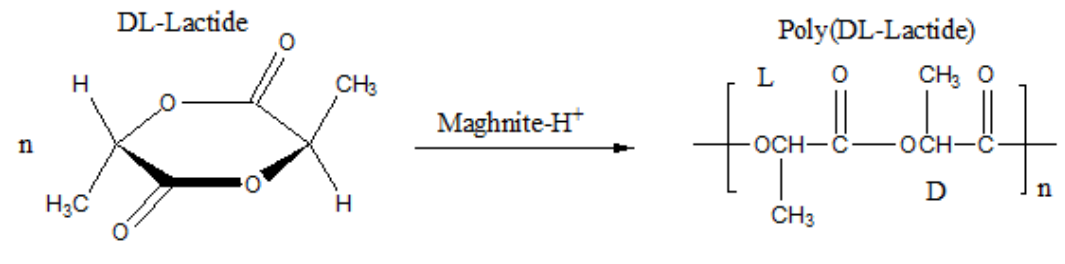
Scheme 1. Polymerization of D,L- Lactide by Maghnite-H